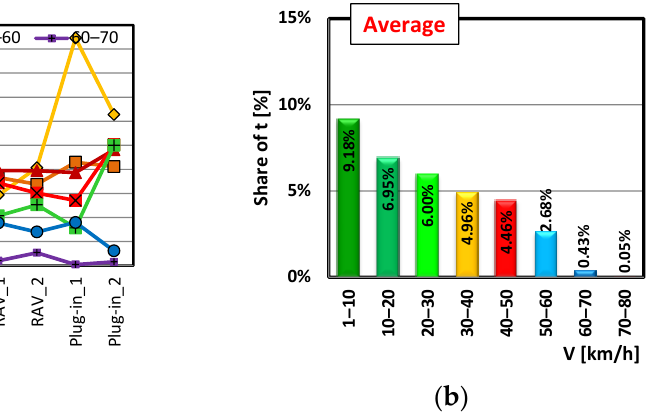
It is possible to determine the proportion of time moving in electric mode for each vehicle tested (Figure 12). The research concluded that each electric vehicle moves almost 10% of the time in electric mode for speeds up to 10 km/h; the higher the speed, the more